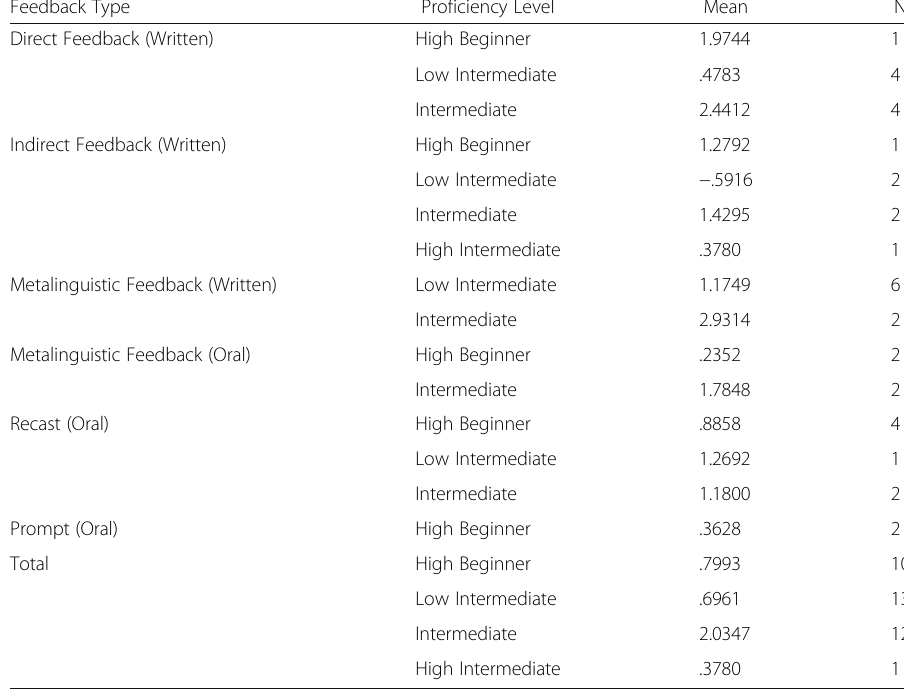
Table 4 Feedback Types by Proficiency Level Feedback